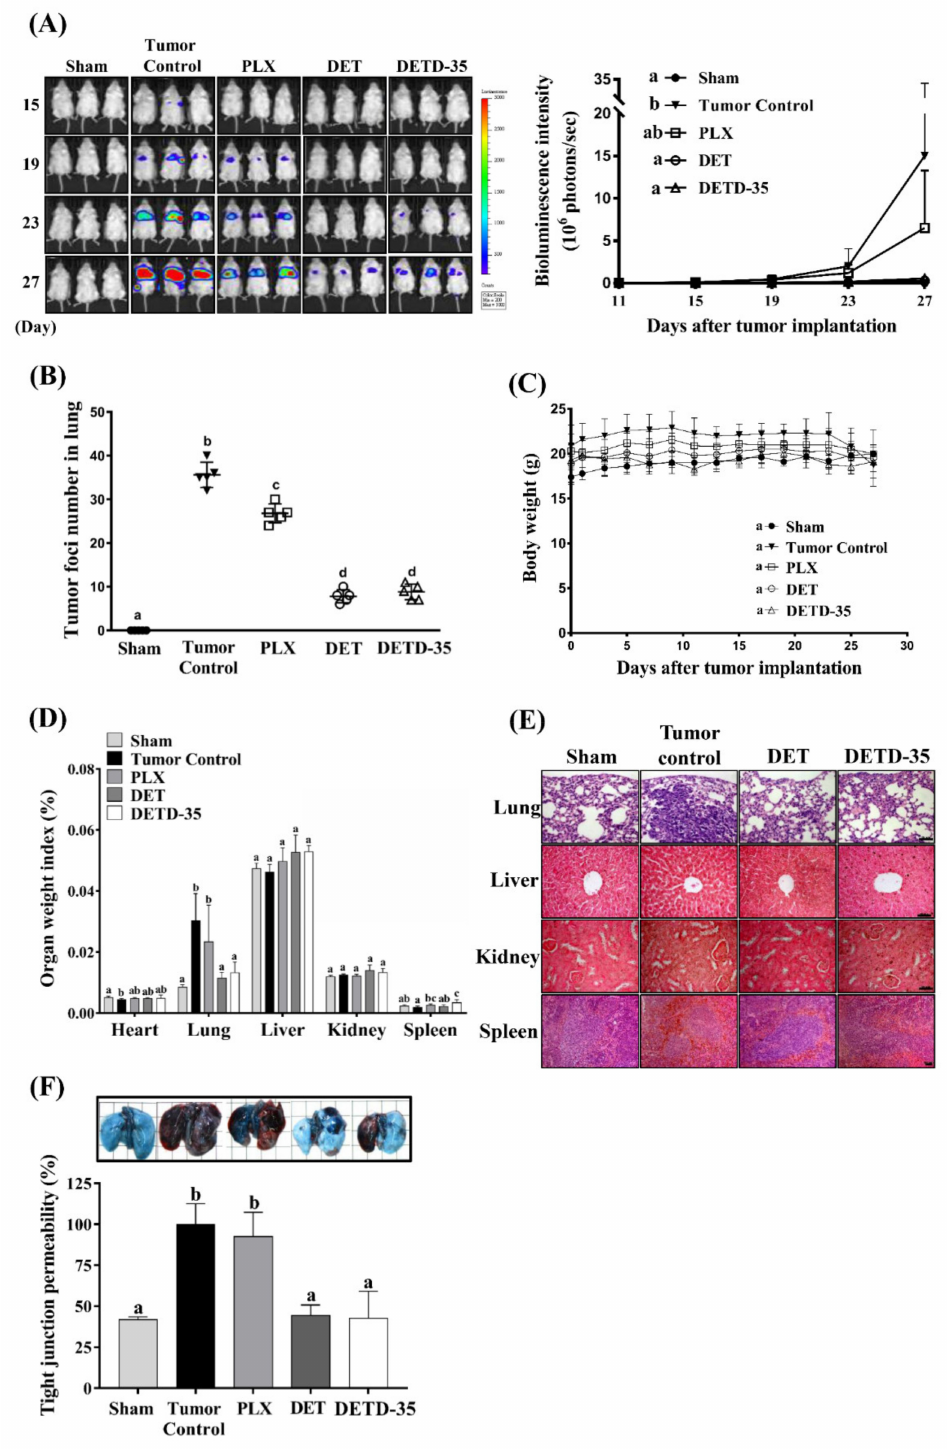
Figure 6. Effect of DET, DETD-35 and PLX on A375LM5 IF4g/Luc lung metastasis in a xenograft mouse model. ( A ) Representative images of bioluminescence imaging (BLI) in the mice (left); the inhibitory effect of compounds on A375LM5 IF4g/Luc lung metastasis in NOD/SCID mice shown by BLI between day 11 and day 27 (right). Data are mean ± SD, n = 5. ( B ) The metastatic melanoma nodules in paraffin-embedded lungs were counted, and the data are mean ± SD, n = 5. ( C ) The body weights of the test NOD/SCID mice were recorded during the experiment and are presented as mean ± SD, n = 5. ( D ) Organ weight index was calculated by dividing the organ weight to the body weight of